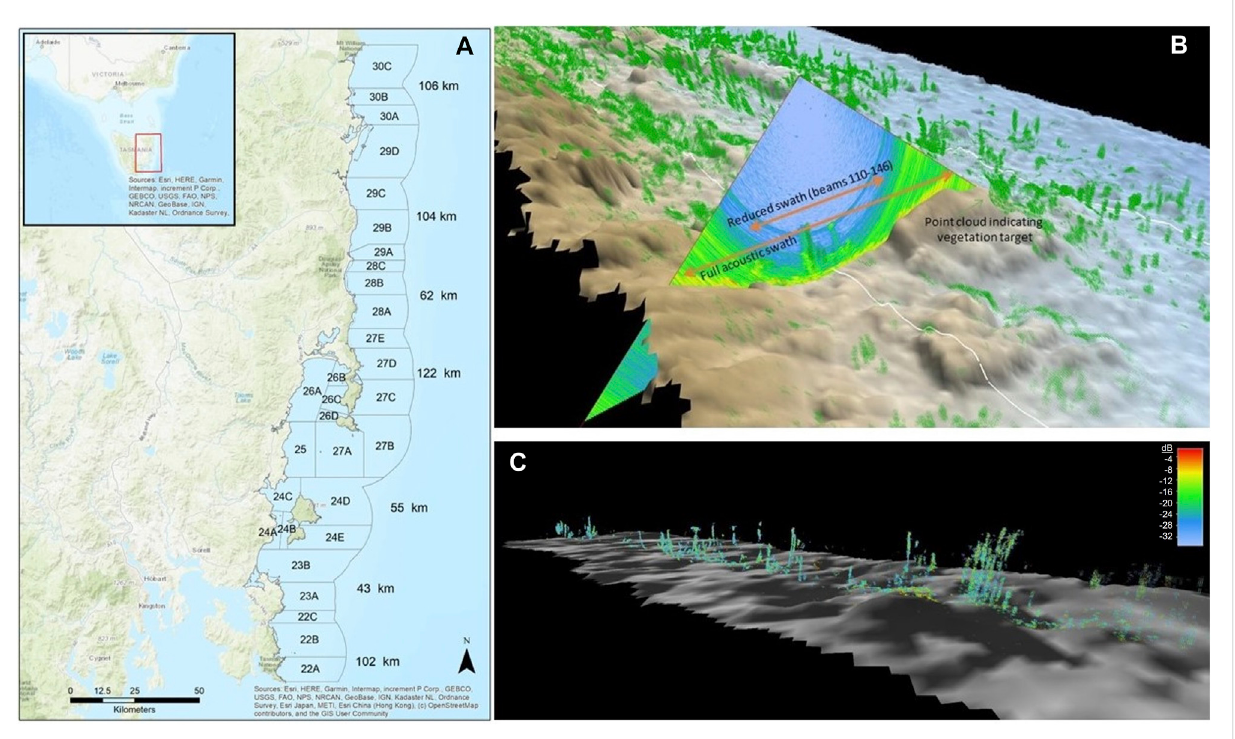
FIGURE 1 (A) Numbered fi sheries management blocks for the abalone industry on the east coast of Tasmania. Each block shows linear distance of survey transect in < 20 m water depth. (B) Multibeam acoustic swath visualised over the benthic terrain model. Green point cloud indicates features that were extractedfromthewatercolumn. (C) Theremainingpointcloudcouldbe fi lteredbydBtoextractestimatesofsignalstrengthwhichrelatestovegetation